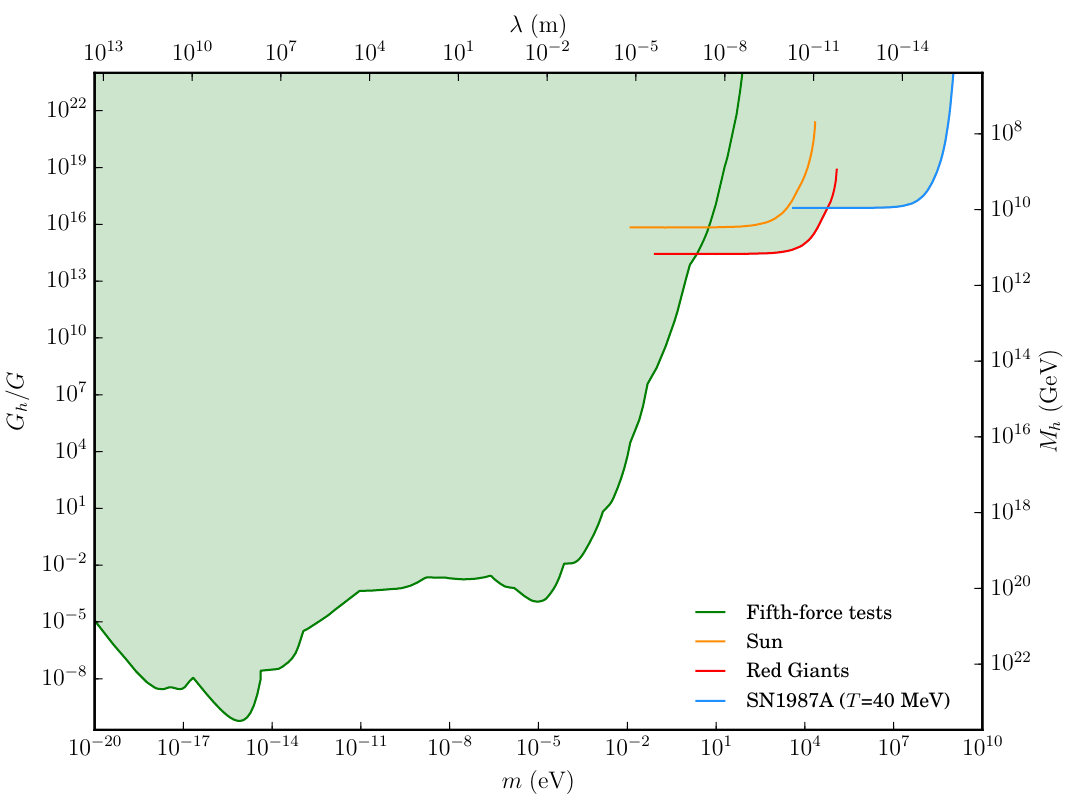
Figure 6 . Constraints on the hidden-graviton mass and coupling G h , relative to the standard- graviton coupling. The shadowed region is excluded by (cid:12)fth-force tests and energy-loss restrictions, derived in this work. The two additional axes represent the distance scale (cid:21) = 1 =m and the energy scale M h = 1 = p 8 (cid:25)G h